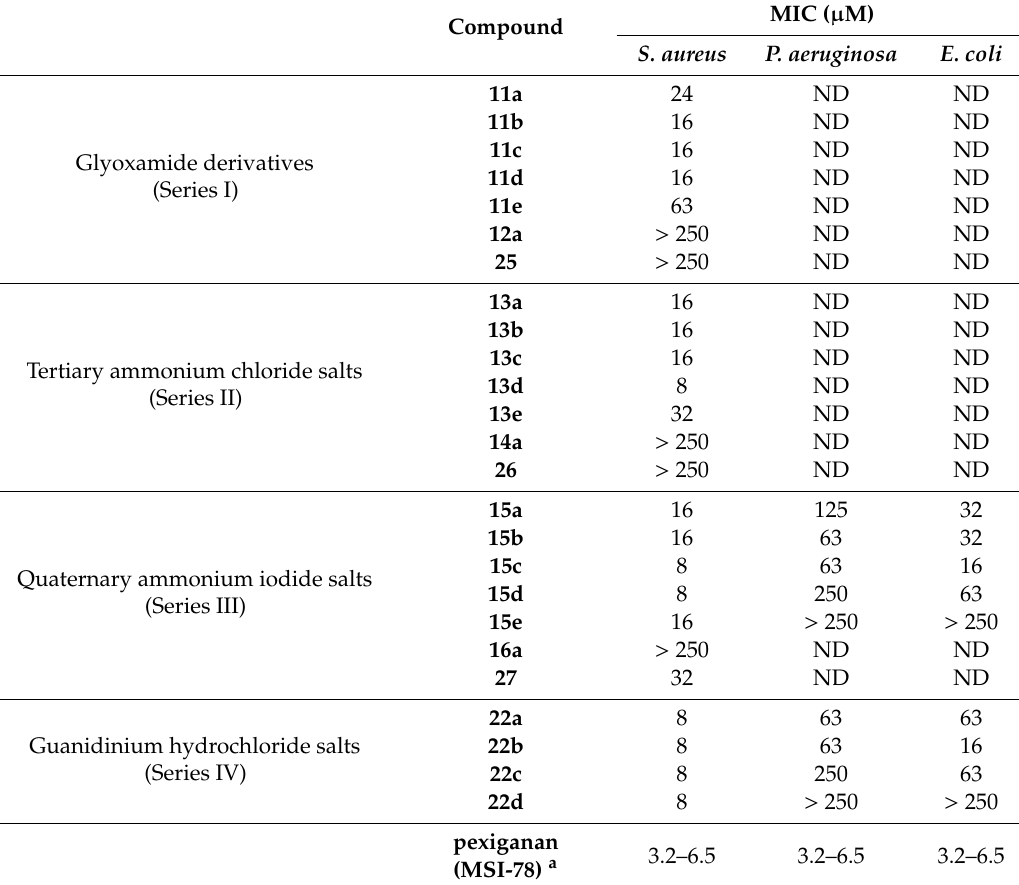
Table 1. Antibacterial activity (minimum inhibitory concentration, MIC) of biphenylglyoxamide derivatives against di ff erent strains of